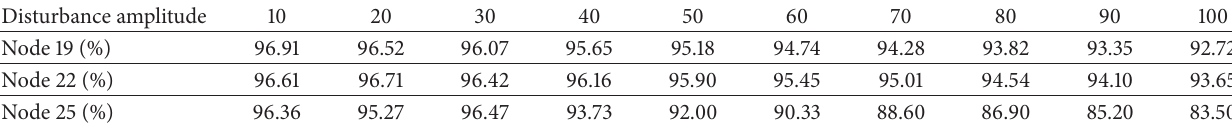
Table 9: 𝑦 -direction vibration attenuation ratio of nodes 19, 22, and 25 with different amplitude sinusoidal disturbance.